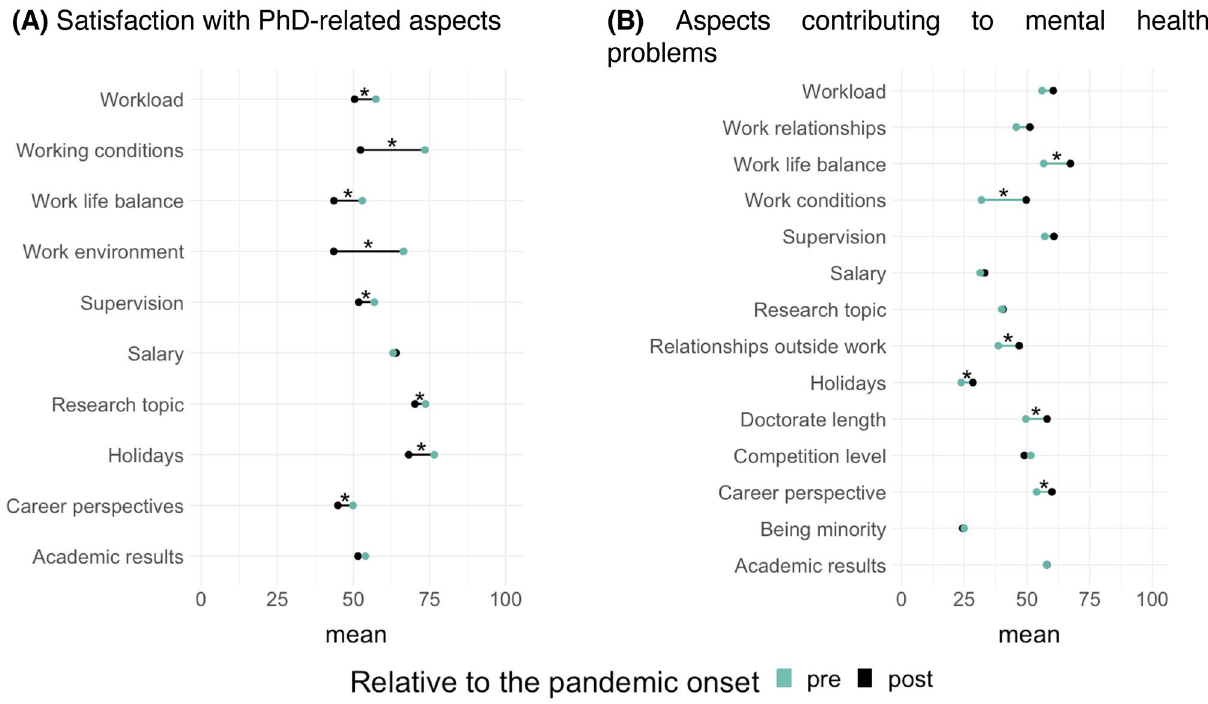
Figure 6. Average ratings of satisfaction with PhD-related aspects and of aspects contributing to mental health problems pre- and post-pandemic onset. The asterisks mark items for which t-tests reached statistical significance ( p < 0.05,